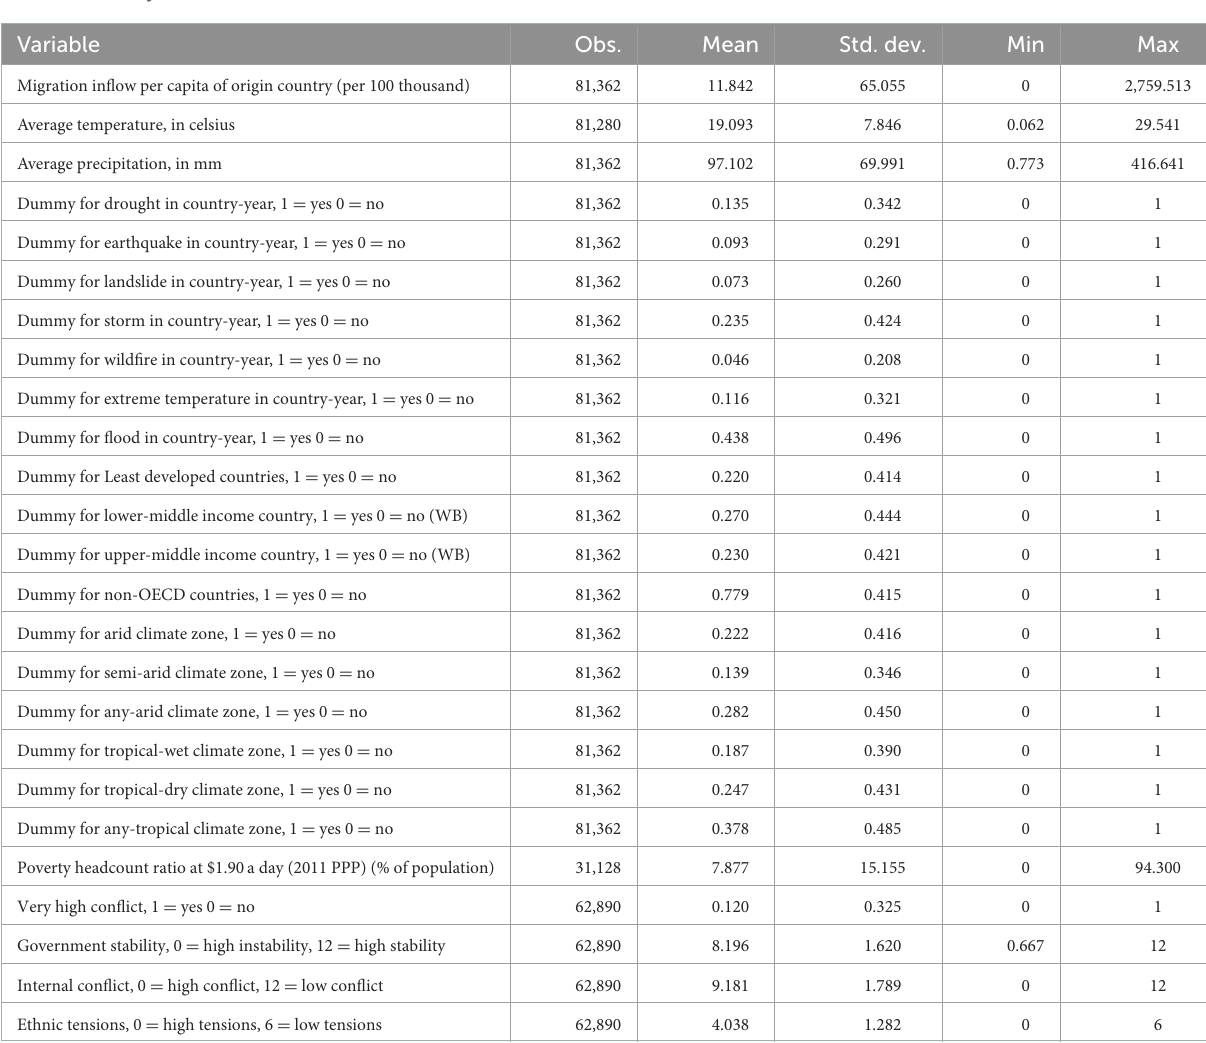
TABLE 1 Summary statistics.